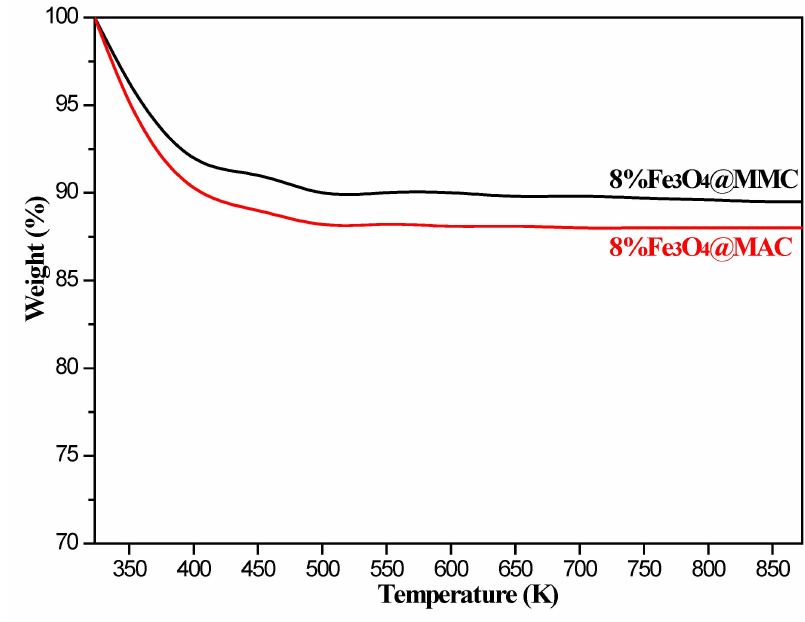
Figure 7. TG curves of